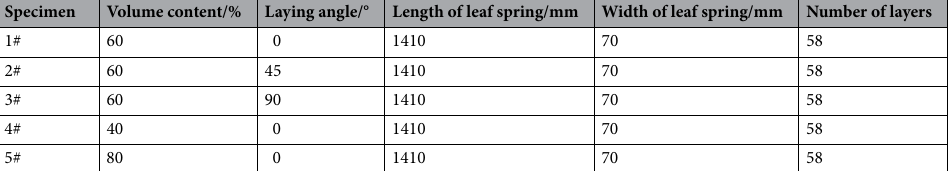
Table 2. Composite material leaf spring test specimens.